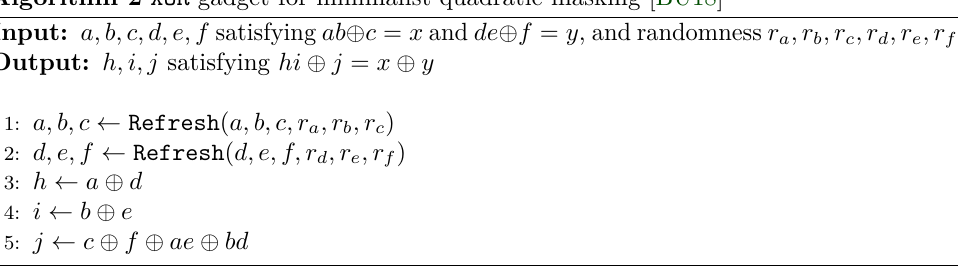
Algorithm 2 XOR gadget for minimalist quadratic masking [BU18]